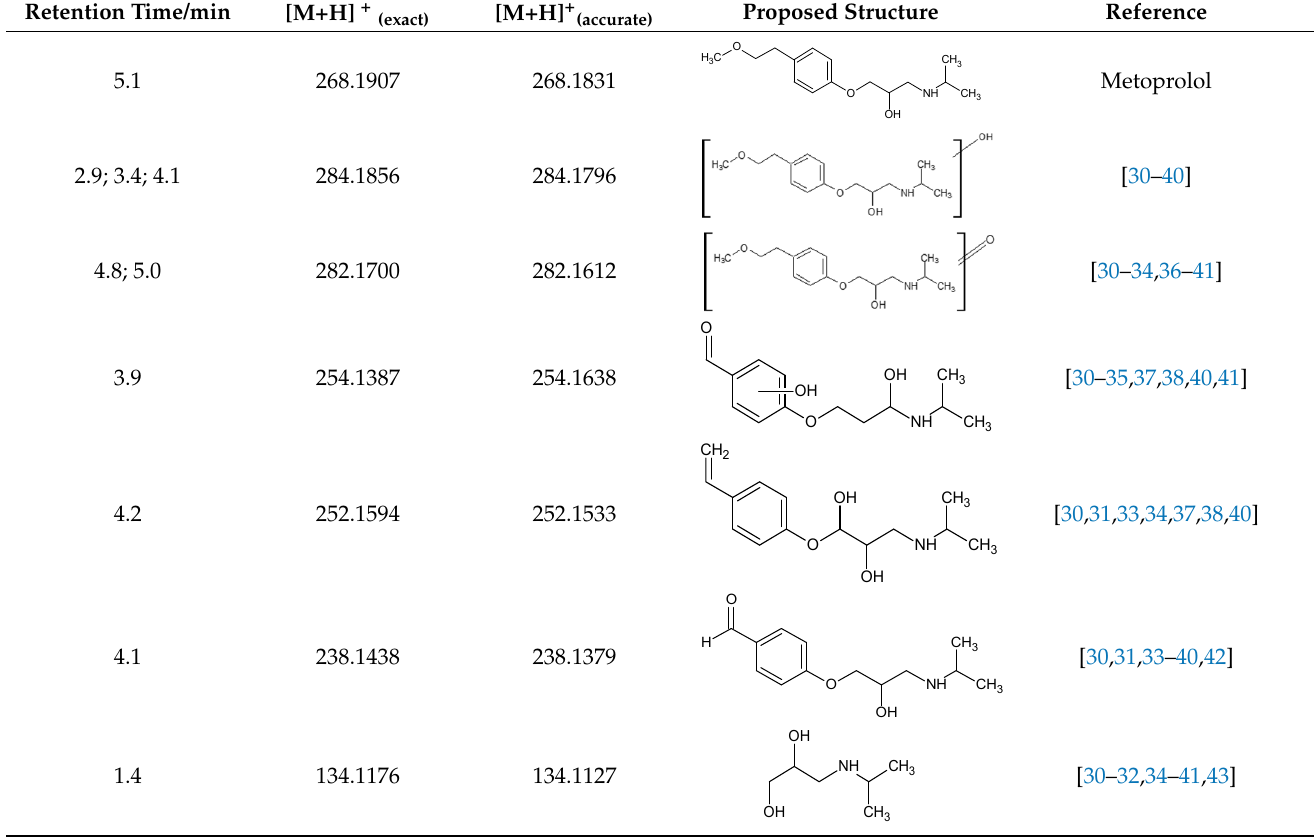
Table 2. Photoinduced transformation products of metoprolol: Retention times, exact and accurate mass, and structure proposal. Retention Time/min